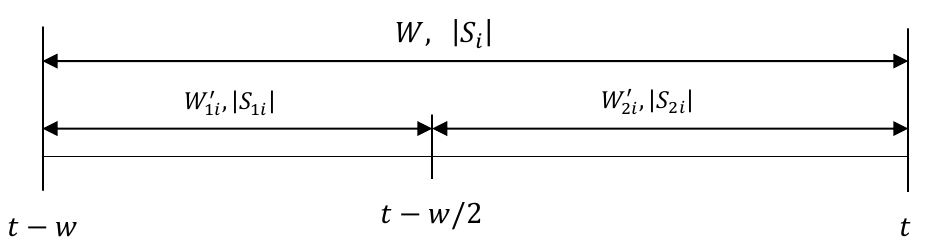
Figure 1. Illustration of the sub-ranges in the smoothing